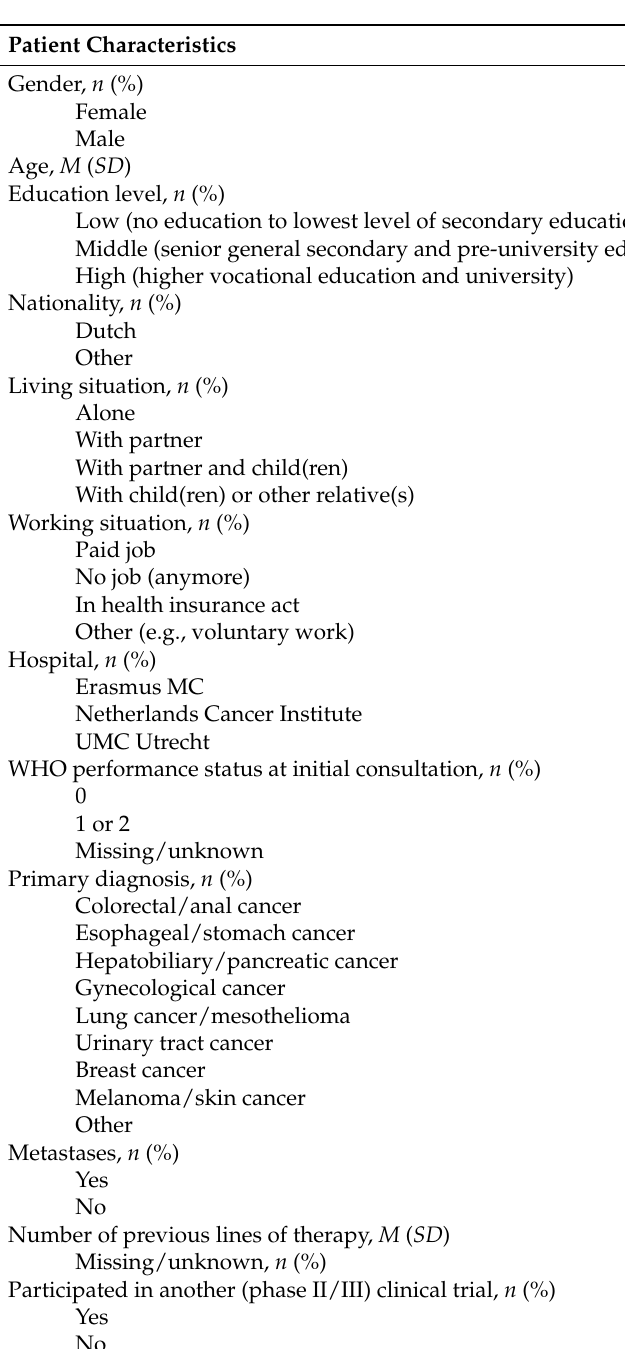
Table 2. Patient characteristics ( n =